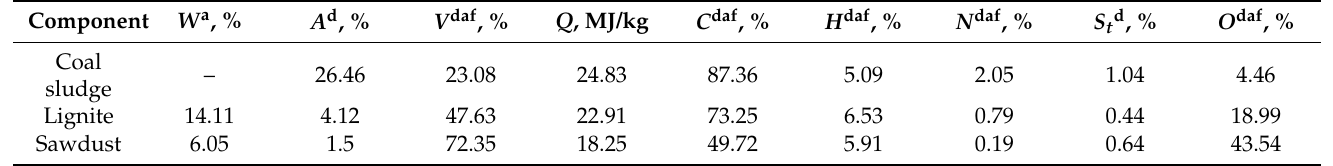
Table 1. Results of elemental and technical analysis of fuel mixture solid components.